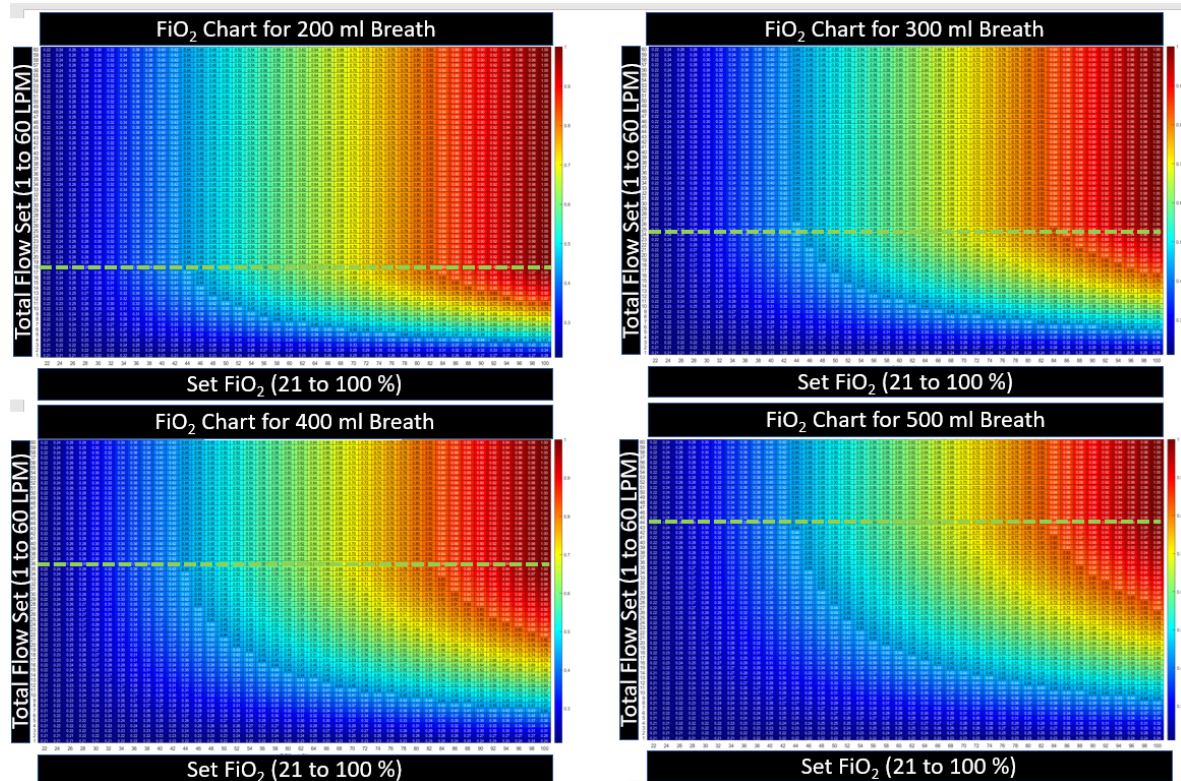
Figure 5. A side-by-side comparison F i O 2 for the four breath sizes shows that as breath size increases in depth, and PIF increases, the flow setting must be above the maximum breath’s PIF to maintain the set F i O 2 for all breaths. The green line in each chart above represents the PIF for that size breath. The tracheal F i O 2 increases below the green line and remains constant in each column above the green line, indicating that setting flow equivalent to PIF is sufficient to achieve the desired F i O 2 . The color convention is described in Section 2.3.2. These charts are meant to show qualitatively, as breaths get larger at the same settings, the charts become more bluish, indicating that tracheal F i O 2 is lower at the same setting when breath depth increases.